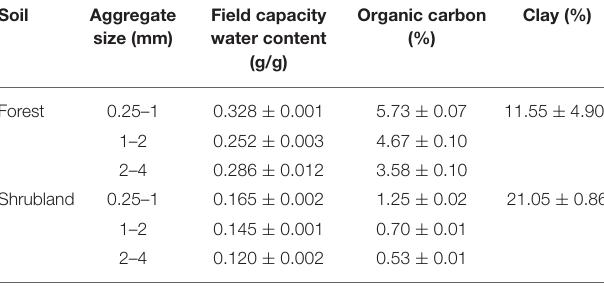
TABLE 1 | Characterization of studied soils (mean ± standard error, where n =